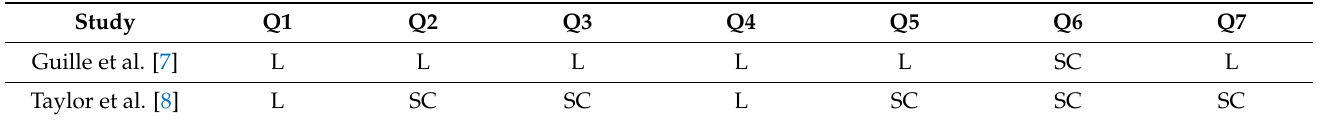
Table 2. The risk of bias in the included